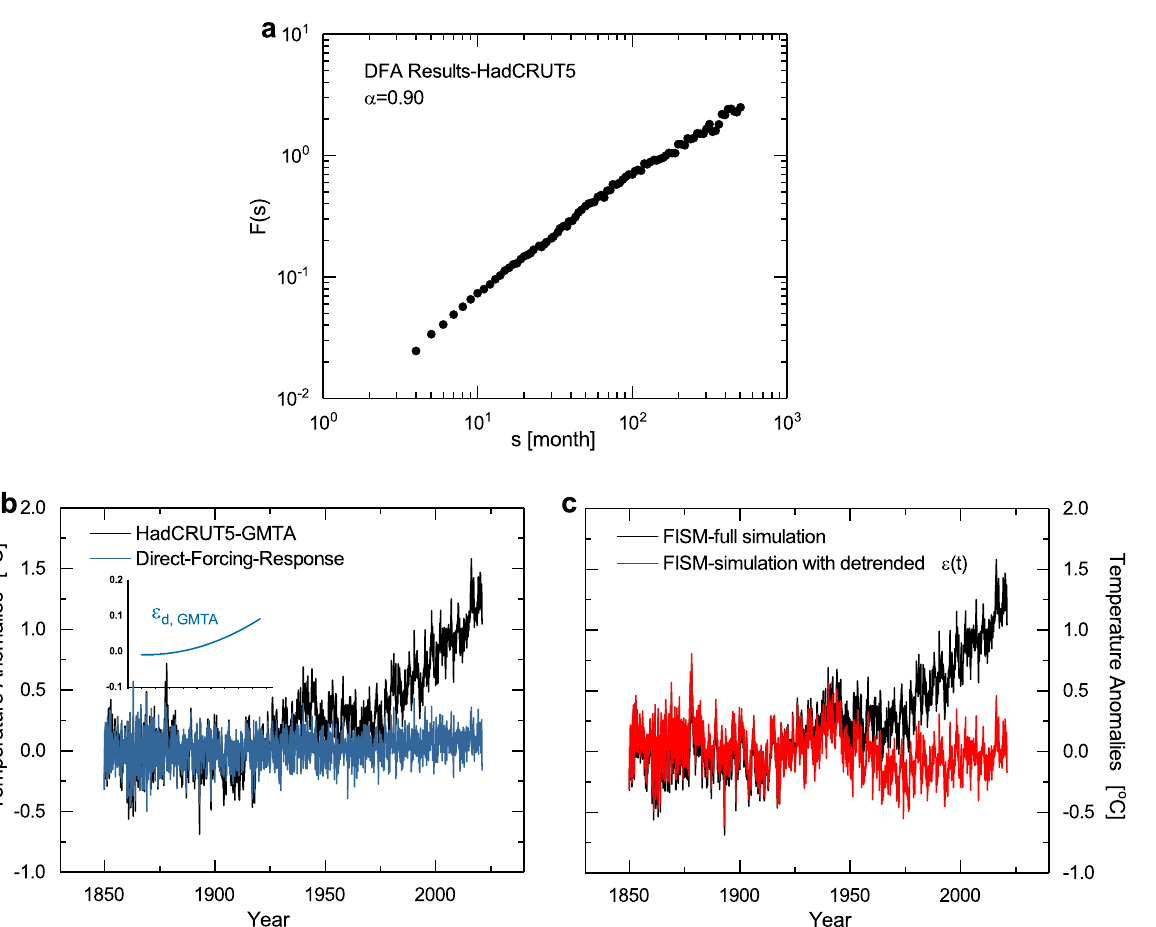
Fig. 1 DFA results of the GMTA and the corresponding extracted direct-forcing-response. a The DFA result of the historical global mean surface temperature anomalies (GMTA), and b the extracted direct-forcing-response. In the inserted sub- fi gure, the trend of the direct-forcing- response (denoted as ε d ) detected from the Ensemble Empirical Mode Decomposition (EEMD) analysis is shown. By feeding the extracted direct-forcing-response back to the FISM model, the historical GMTA is fully reproduced, see the black curve in ( c ). If ε d is removed, however, by feeding the detrended direct-forcing-response to FISM, only natural variabilities of the GMTA are reproduced without long-term warming trend, see the red curve in ( c